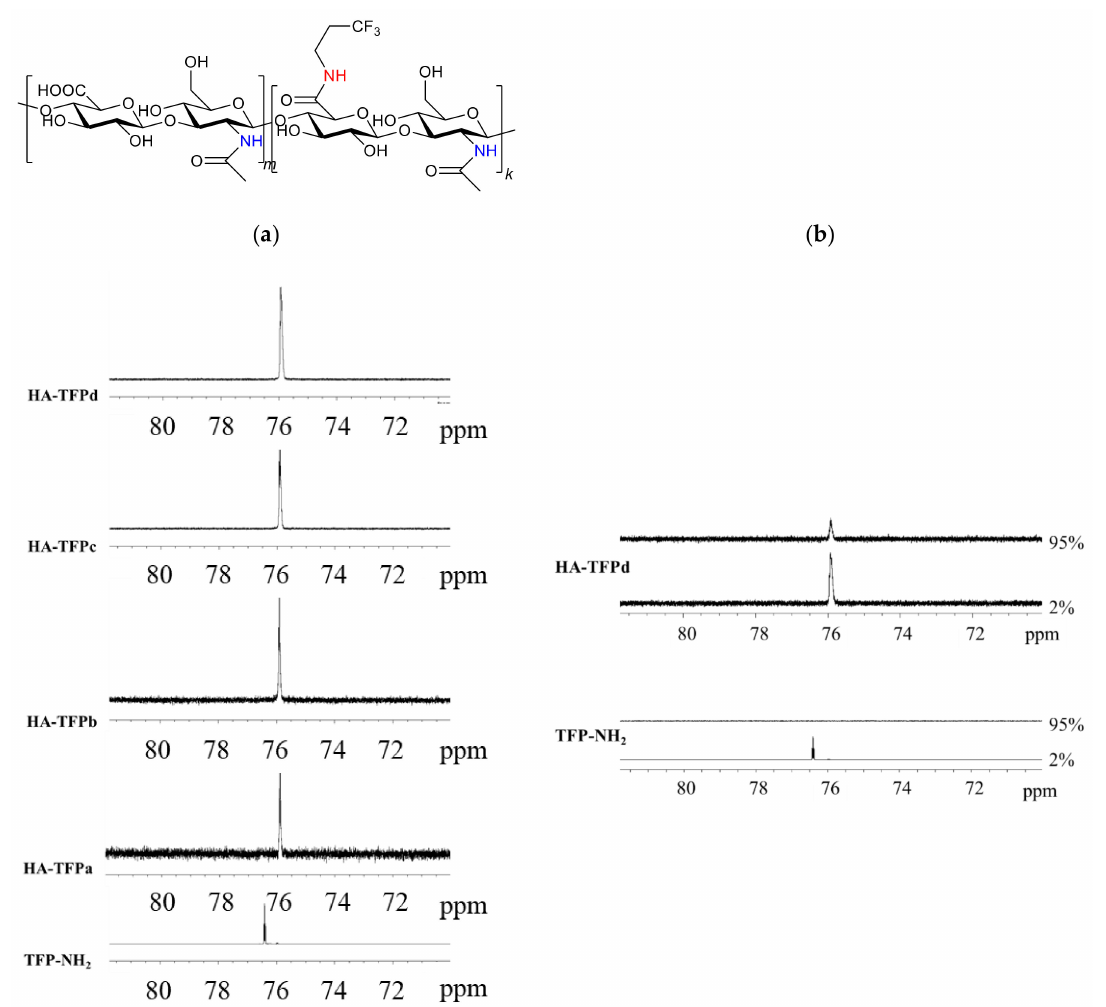
Figure 3. ( a ) 19 F NMR spectra of trifluoropropyl functionalized HA: HA-TFPa , HA-TFPb , HA-TFPc and HA-TFPd for initial molar ratios (NH 2 /COOH) = 10 (bottom), 20, 50, and 100 (top) %, respectively; TFP-NH 2 19 F spectrum is given as a reference (470.64 MHz, 318 K, DMSO- d 6 ). ( b ) One-dimensional (1D) diffusion-filtered 19 F NMR spectra of HA-TFPd and TFP-NH 2 with a gradient g of 2% and 95%.